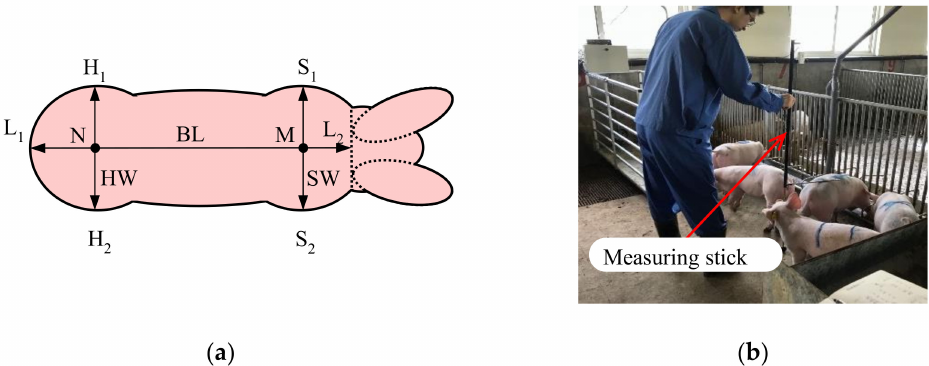
Figure 3. Specific locations of body size parameters and measurement of body size: ( a ) specific locations of body size parameters; ( b ) body size measurement using a measuring